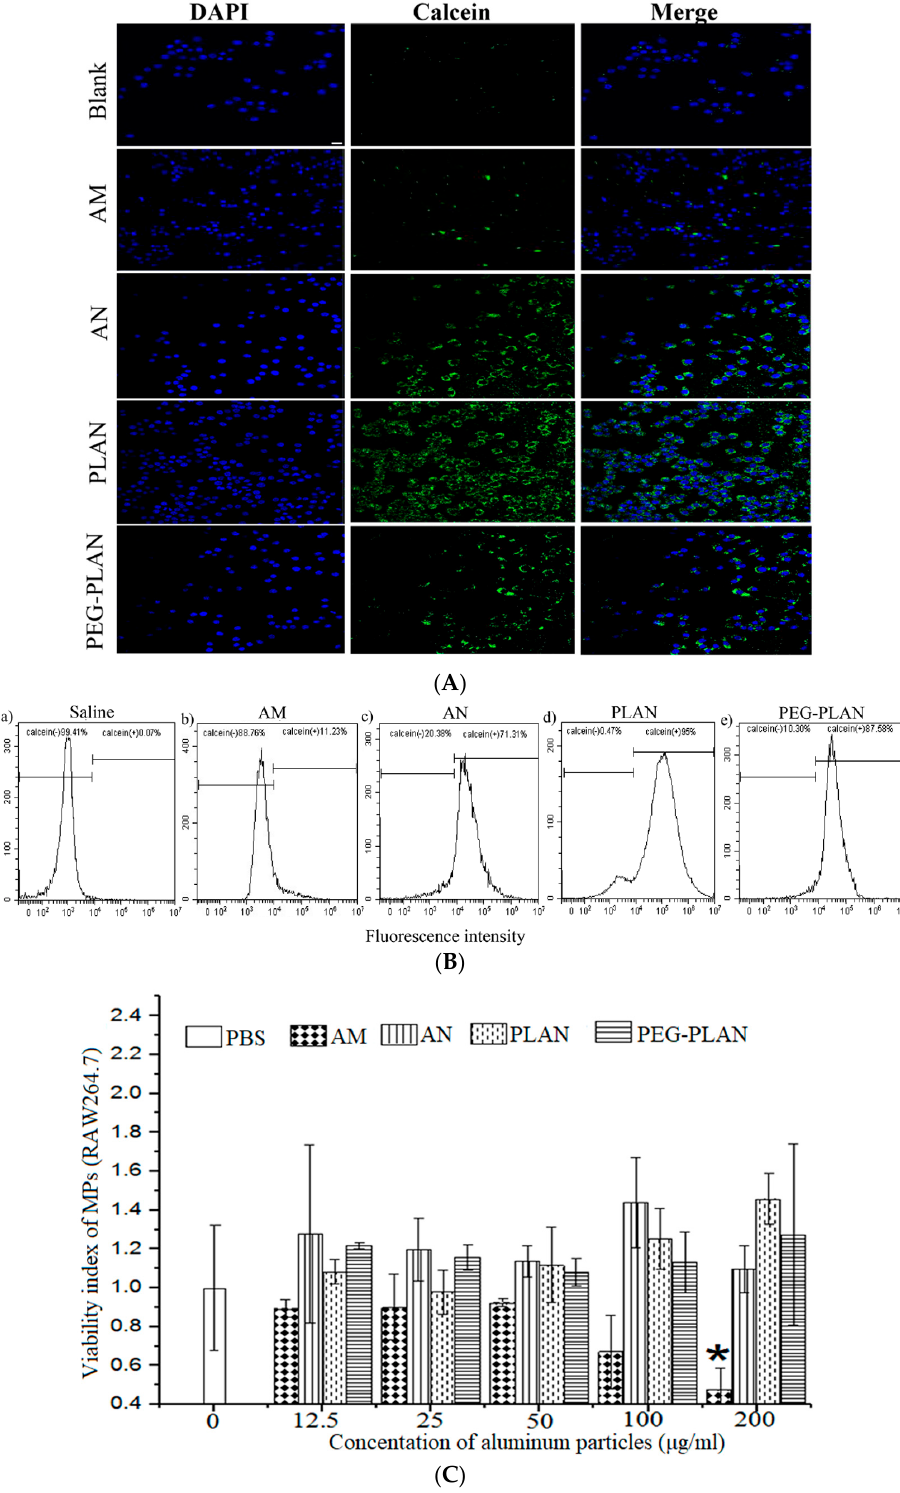
Figure 2. APC uptake and the cytotoxicity of the Al-based vaccine adjuvant-delivery systems (VADSs) ( n = 3). ( A ) Fluorescent images showing mouse bone marrow-derived dendritic cells (BMDC) uptake of free calcein or the calcein-loaded Al-based carriers (bar = 10 μ m, applicable to all panels). ( B ) The percentages of APCs that had internalized the Al-VADSs with the data gained by flow cytometry. ( C ) APC viability index derived from the 3-(4,5-dimethylthiazol-2-yl)-2,5-diphenyltetrazolium bromide (MTT) data obtained through incubation of murine MPs (macrophages) (RAW264.7) with di ff erent